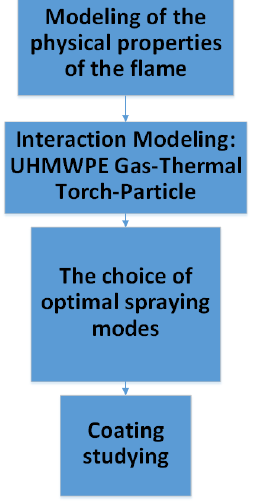
Figure 1. General scheme of the